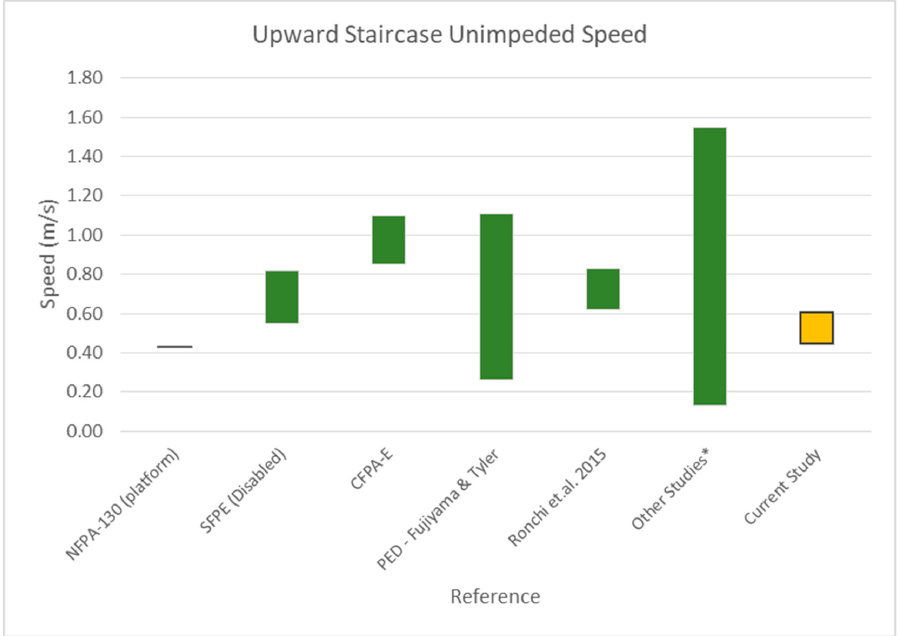
Figure 21. Walking speed (m/s) during unimpeded travelling in upward staircase synopsis, database from previous studies and current experiment.